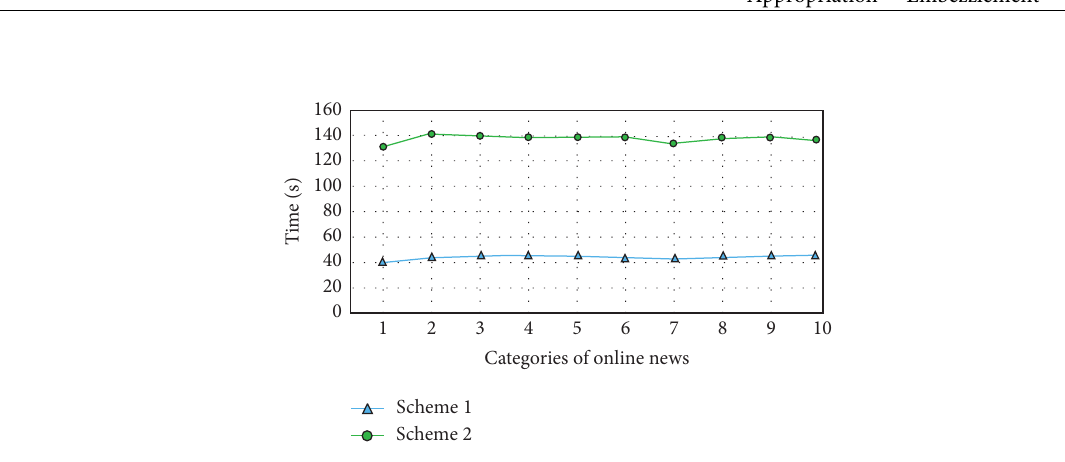
Figure 8: Efficiency comparison chart of keyword extraction.